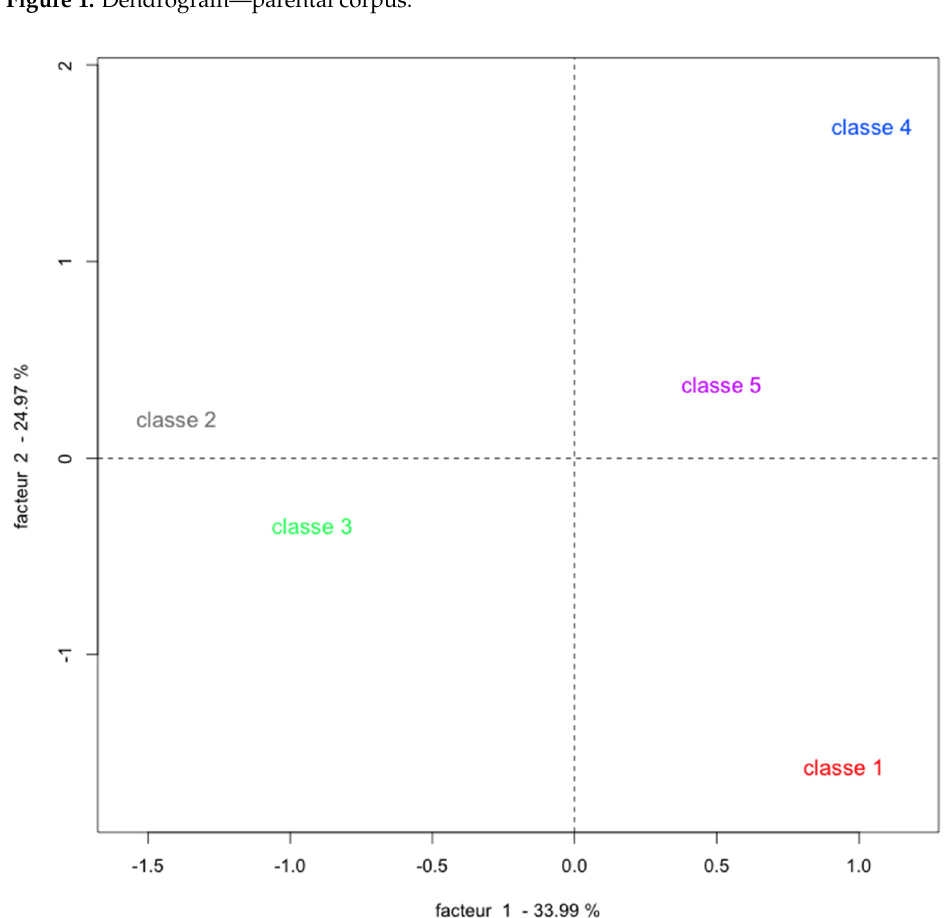
Figure 2. Correspondence factor analysis based on Reinert’s classification—parent corpus. AFC